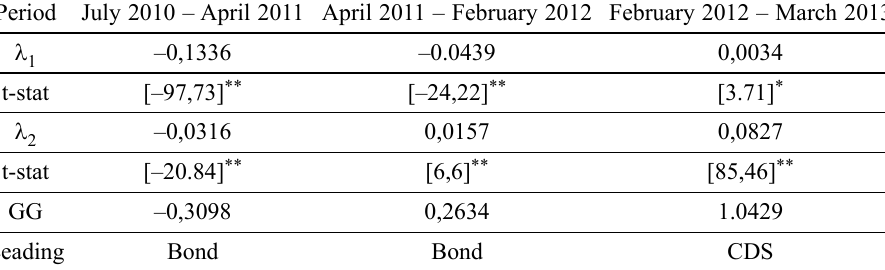
Table 3. Values of coefficients and GG